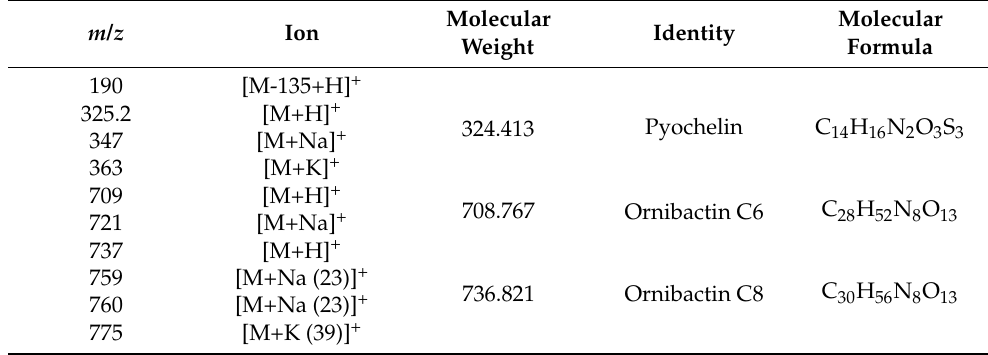
Table 2. Metabolites secreted by Burkholderia sensu lato maize rhizosphere strains as identified by MS/MS analysis.